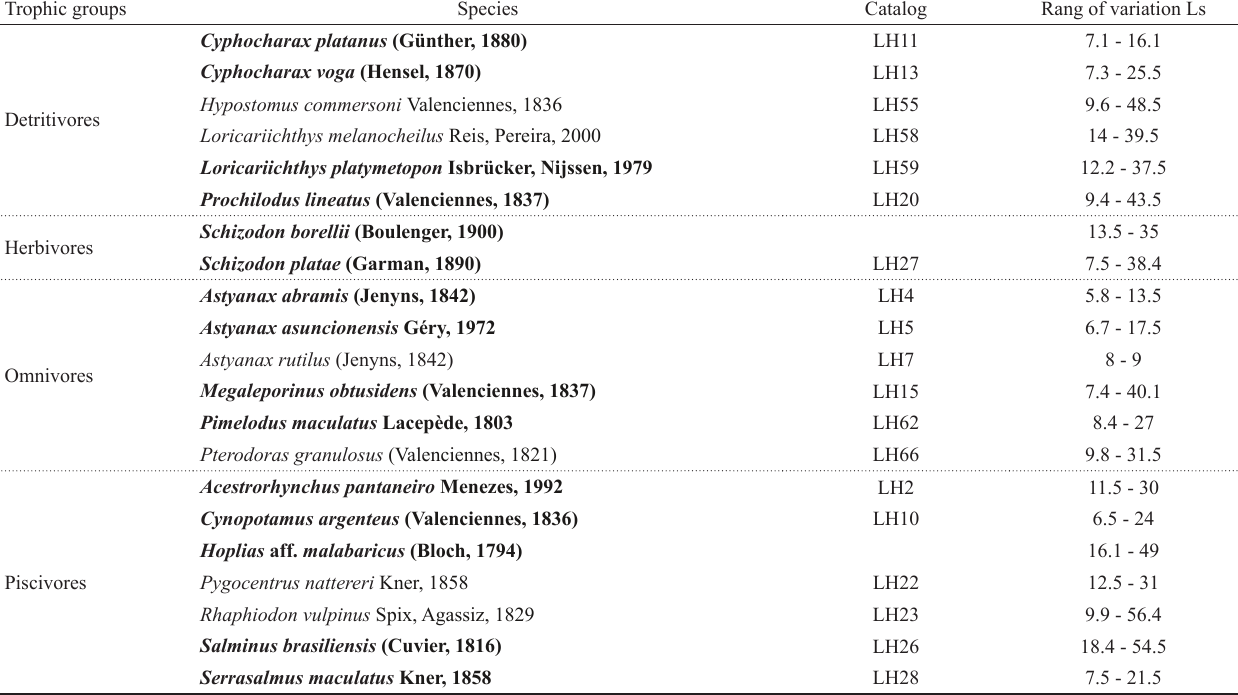
Tab. 2. Species by trophic group in the 2010-2012 samples and the respective catalog number of voucher specimens of each specie. Rang of Ls variation (cm) by species per trophic group considering sizes obtained throughout the study period. Species selected for analyses by species are indicated in bold.